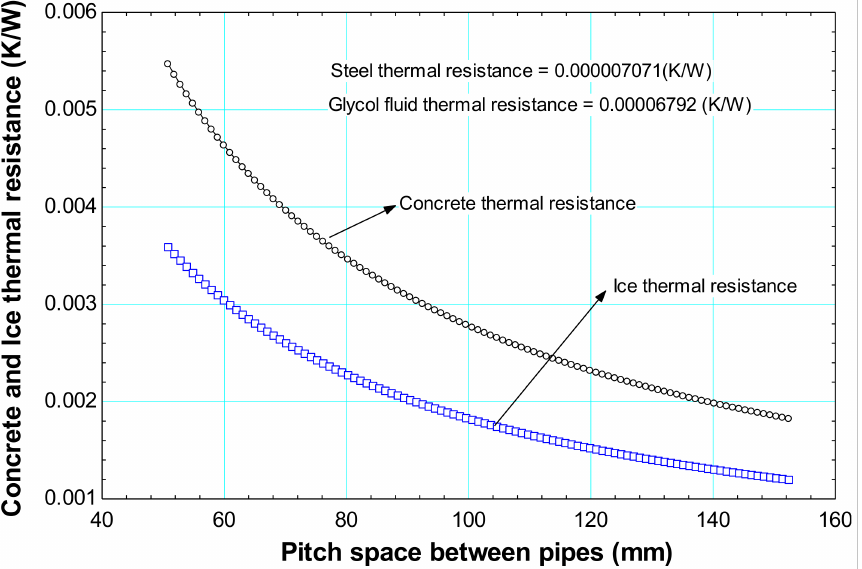
Figure 5. Thermal resistance at the different pitch spaces.